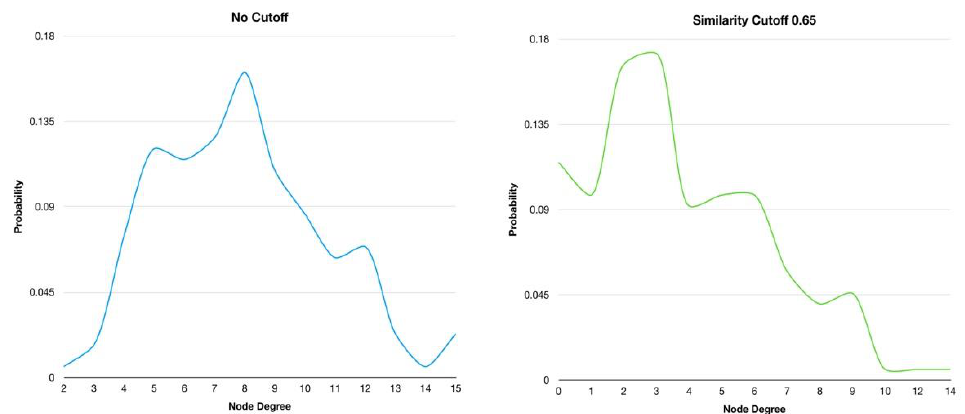
Figure 3. Degree distribution of the HSPNs corresponding to the 174 ABFPs with no similarity cutoff and after applying a cutoff of 0.65.